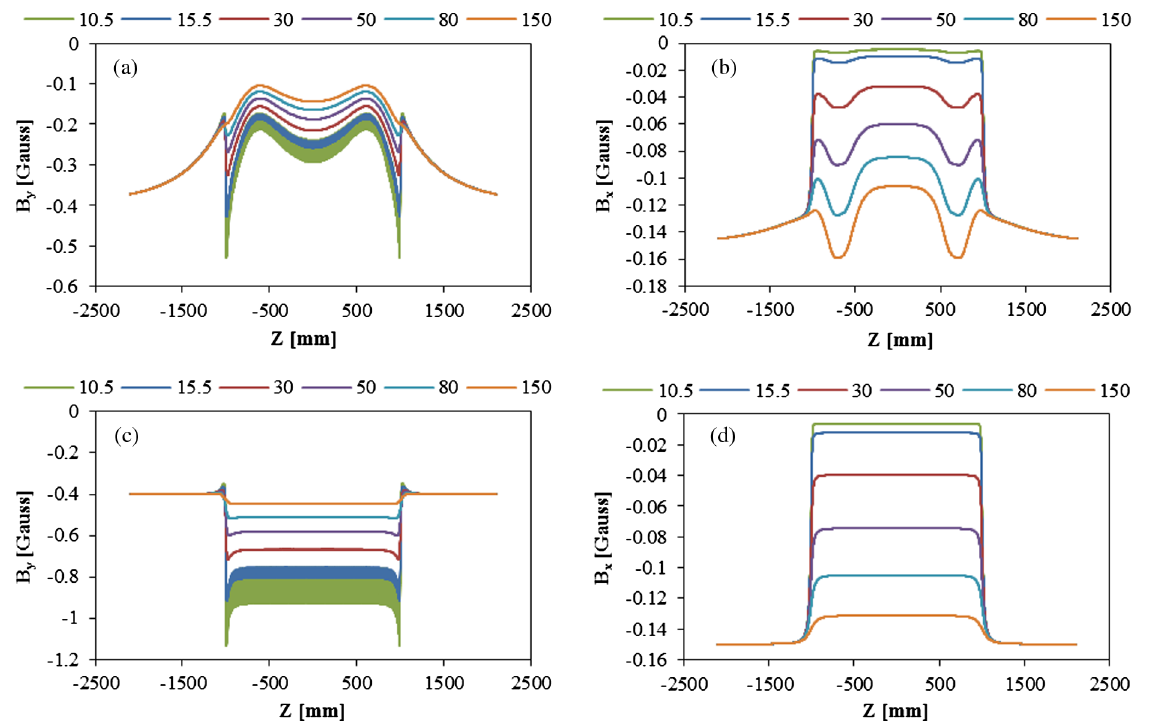
FIG. 13. Earth ’ s field propagation in the APS27 #5s magnetic structure for different ID ’ s gaps: (a) vertical field propagation with magnetic frame consideration; (b) transverse horizontal field with frame; (c) vertical field without frame; (d) transverse horizontal field without frame.